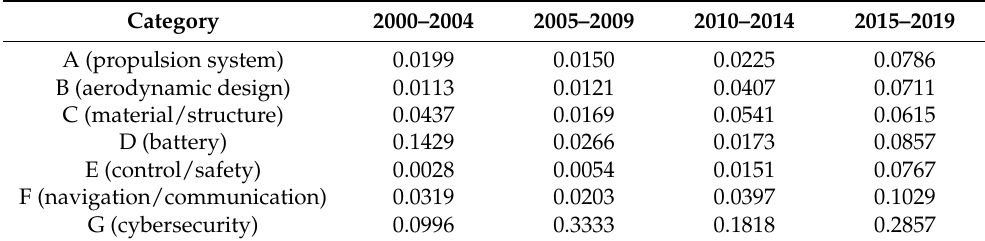
Table 13. Degree centrality by technology.